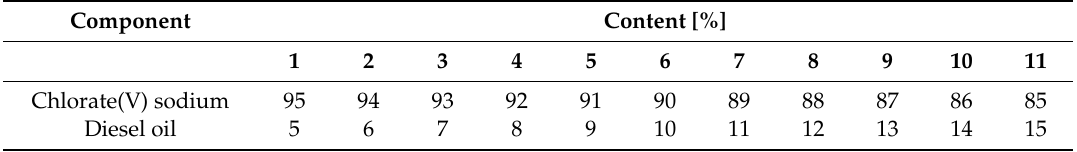
Table 1. Composition of tested gas-generating mixtures (Adapted from